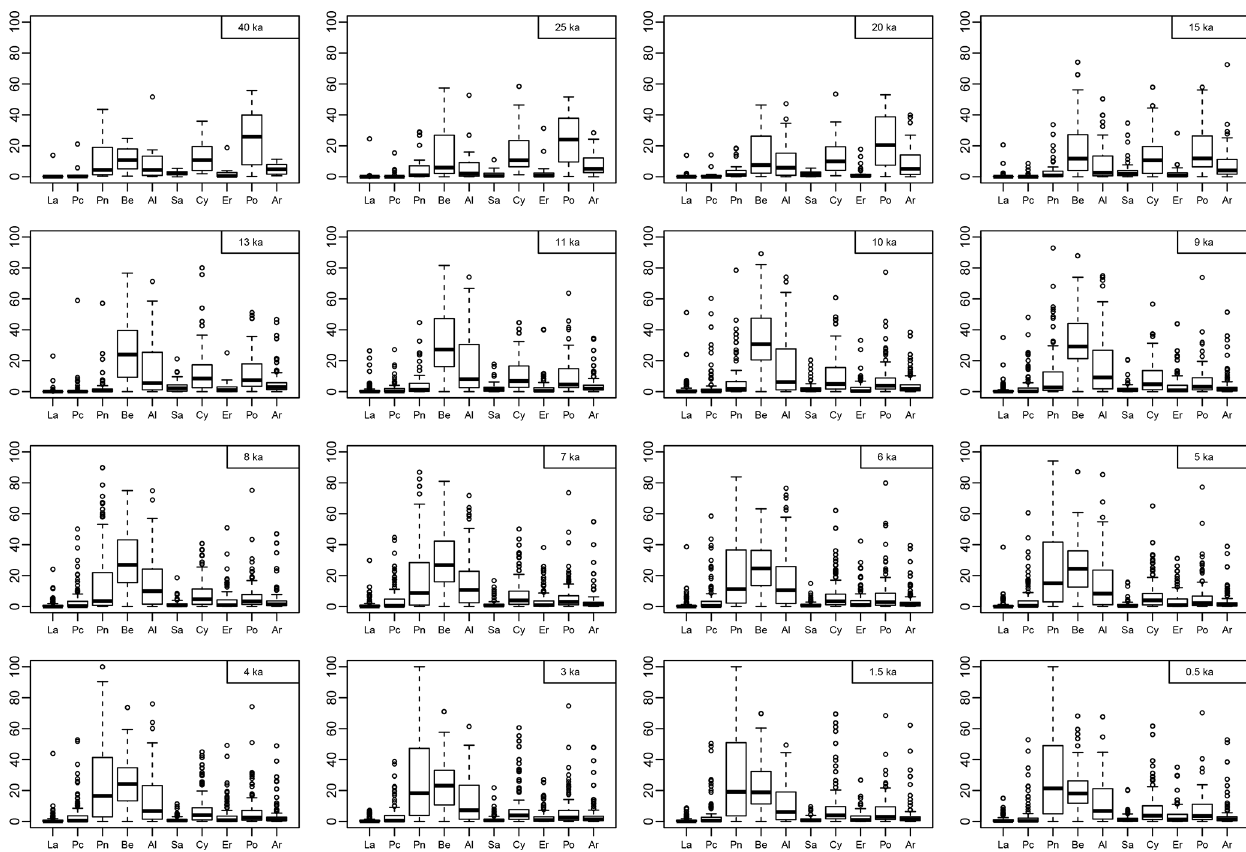
Figure 3. Boxplots of percentages of 10 major pollen taxa at all available sites at key time slices. La: Larix ; Pc: Picea ; Pn: Pinus ; Be: Betula